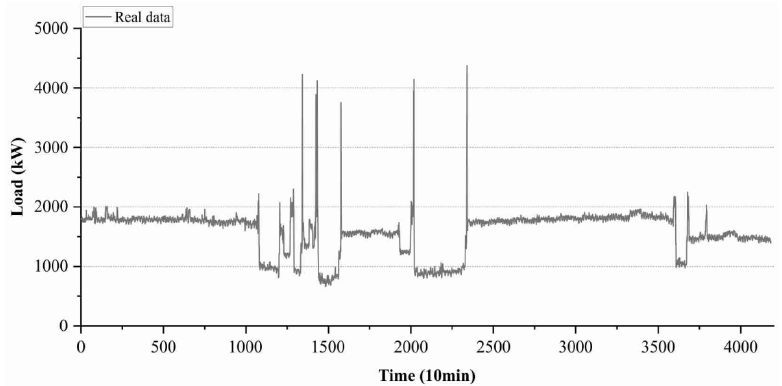
Figure 3. Electric power load data of the ship.